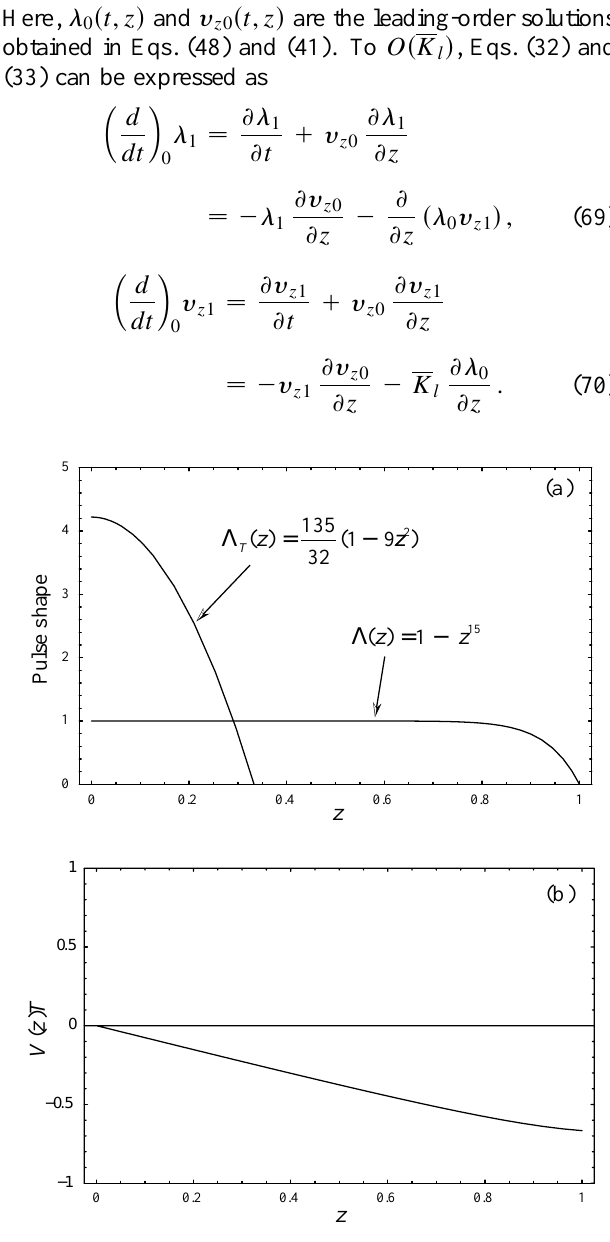
FIG. 5. Initial pulse shape L (cid:2) z (cid:3) (cid:1) 1 2 z 15 and final pulse shape L T (cid:2) z (cid:3) (cid:1) (cid:2) 135 (cid:1) 32 (cid:3) (cid:2) 1 2 9 z 2 (cid:3) are plotted in (a). The ini- tial velocity V (cid:2) z (cid:3) given by Eqs. (56) and (52) is plotted in